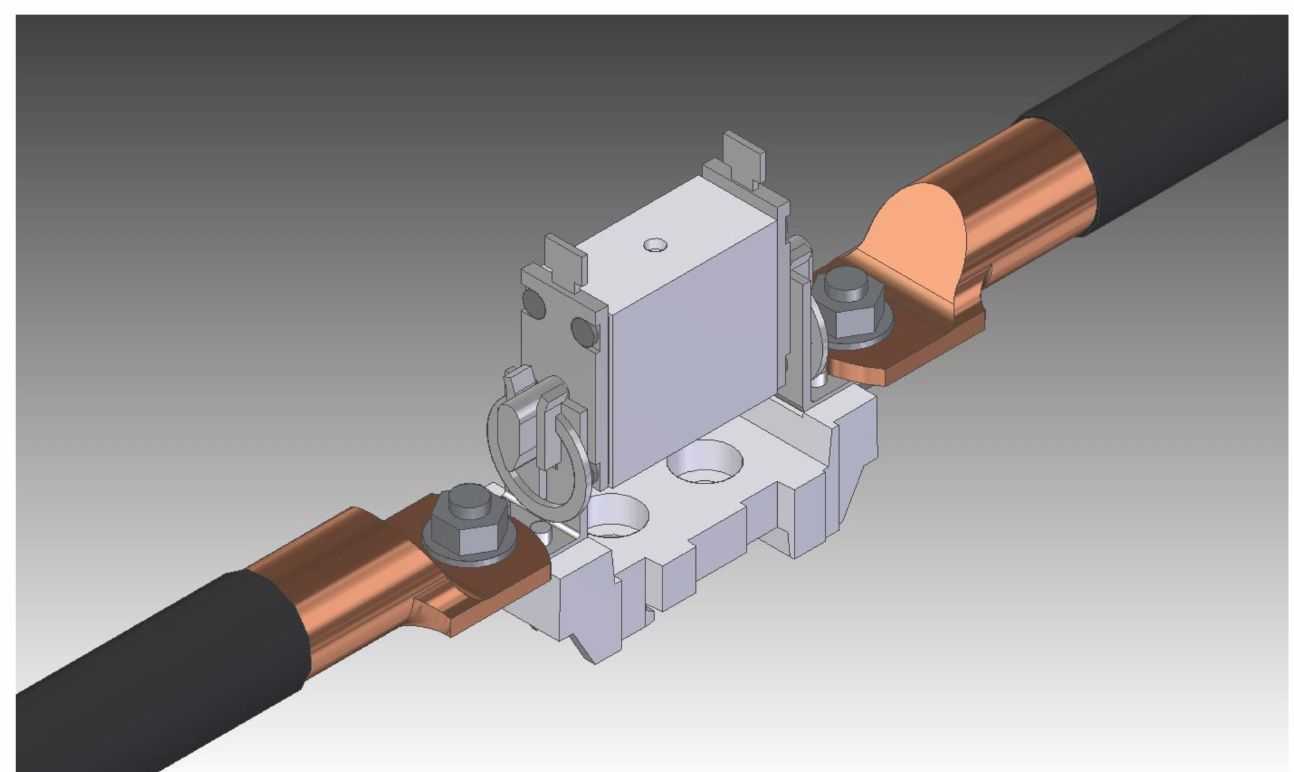
Figure 1. Model of a fuse link mounted in a fuse base during simulation